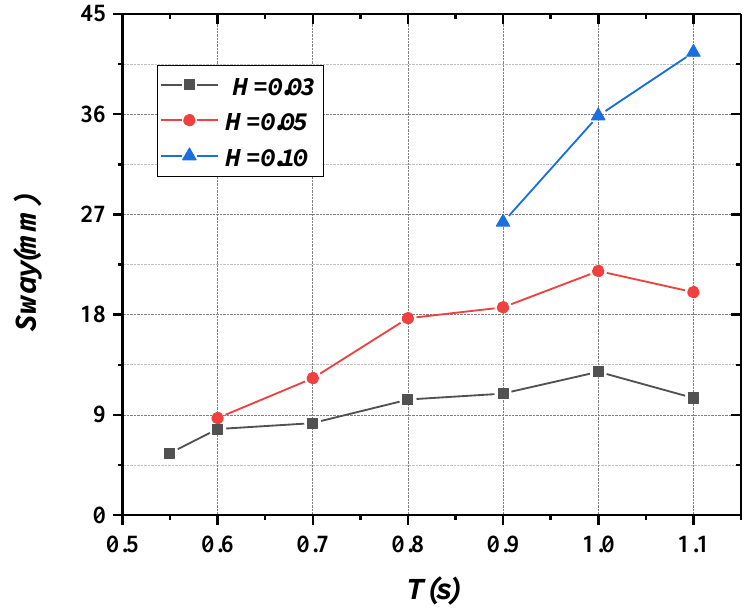
Figure 25. Variations of sway with period and wave height.